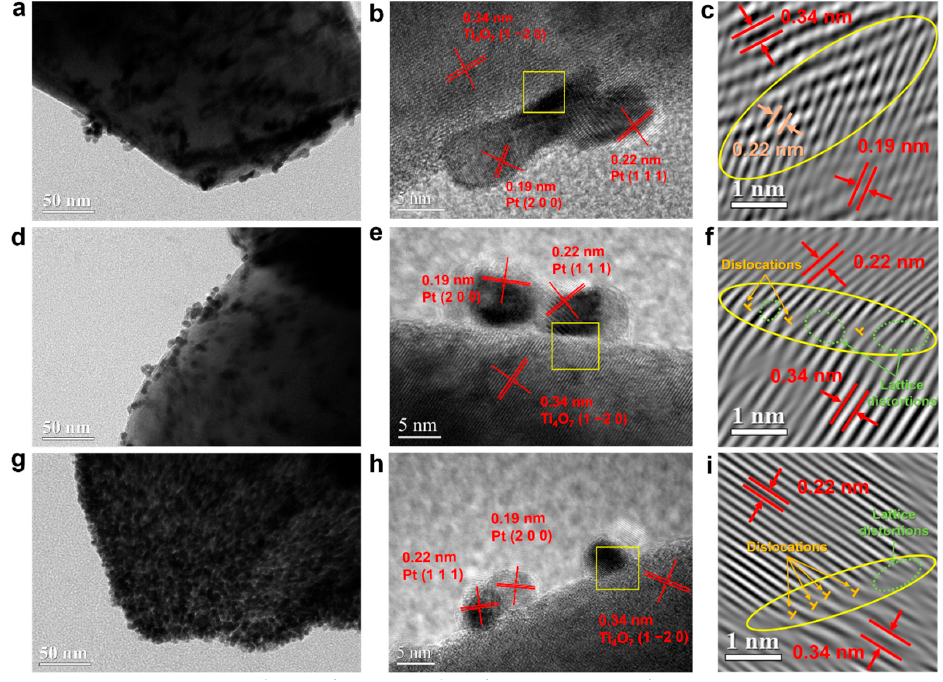
Figure 4. TEM images of ( a ) Pt/Ti 4 O 7 -5; ( d ) Pt/Ti 4 O 7 -10; ( g ) Pt/Ti 4 O 7 -20. HRTEM images of ( b ) Pt/Ti 4 O 7 -5; ( e ) Pt/Ti 4 O 7 -10; ( h ) Pt/Ti 4 O 7 -20. Selected-area IFFT patterns of ( c ) Pt/Ti 4 O 7 -5; ( f ) Pt/Ti 4 O 7 -10; ( i ) Pt/Ti 4 O 7 -20. Figure 4d is the TEM image of Pt/Ti 4 O 7 -10, in which the size of the Pt NPs is about 7.2 nm, which is almost consistent with the particle size obtained from the XRD